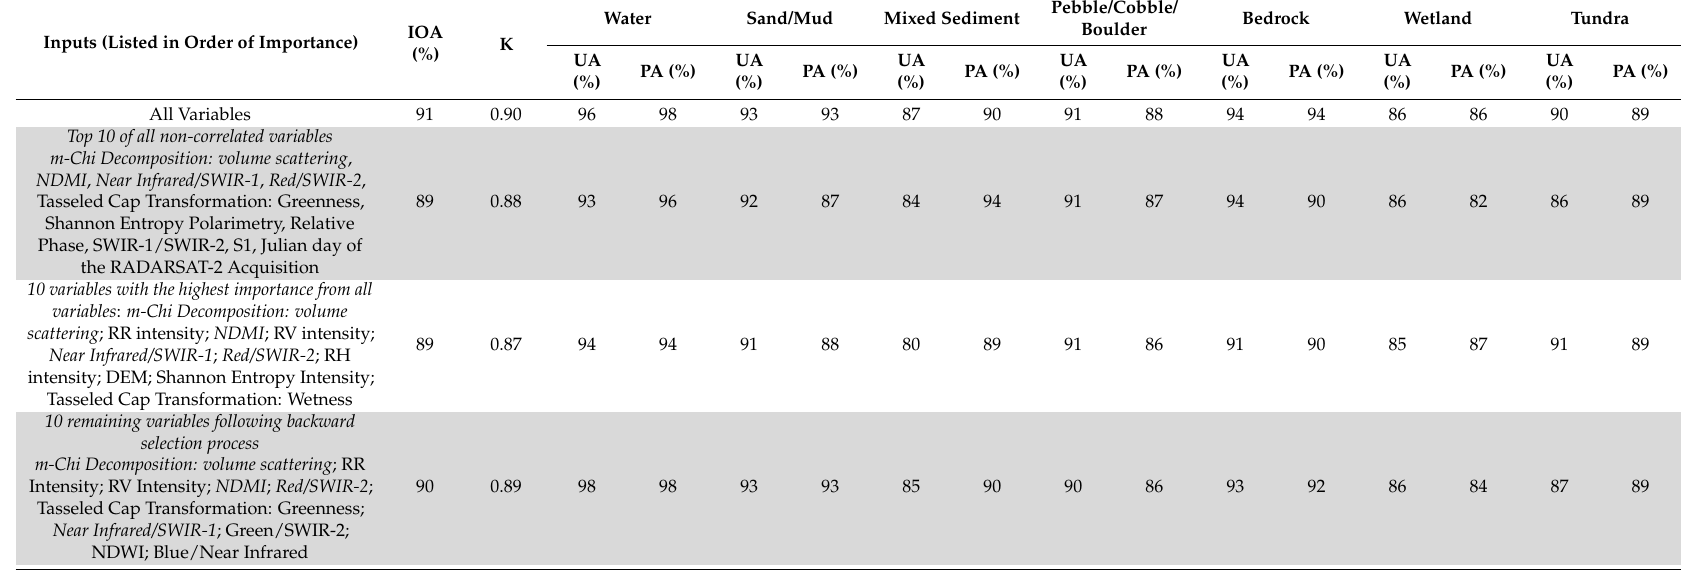
Table 13. Evaluation metrics, including: independent overall accuracy (IOA), Kappa statistic values (K), and per-class user’s and producer’s accuracies (UA and PA) for Random Forest models generated with RCM medium resolution mode CP, Landsat 5, and CDED dataset (i.e., Model 19) based on different sets of variables. Variables included in all three models constructed as part of the variable reduction process are bolded and italicized. Pebble/Cobble/ Water Sand/Mud Mixed Sediment Bedrock Wetland Tundra Boulder Inputs (Listed in Order of Importance) IOA K (%) 89 Top 10 of all non-correlated variables